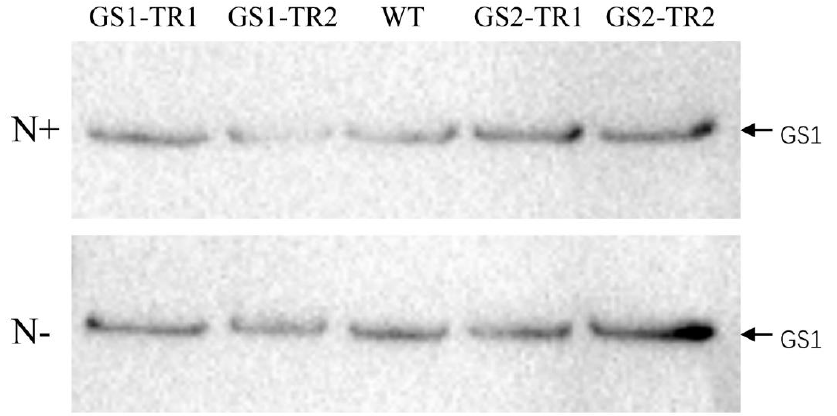
Figure 4. GS expression in the root of GS1-TR, GS2-TR, and the WT grown under a N+ or N − regime. Western blot analysis using various antibodies against wheat cytosolic GS1 and chloroplastic GS2.